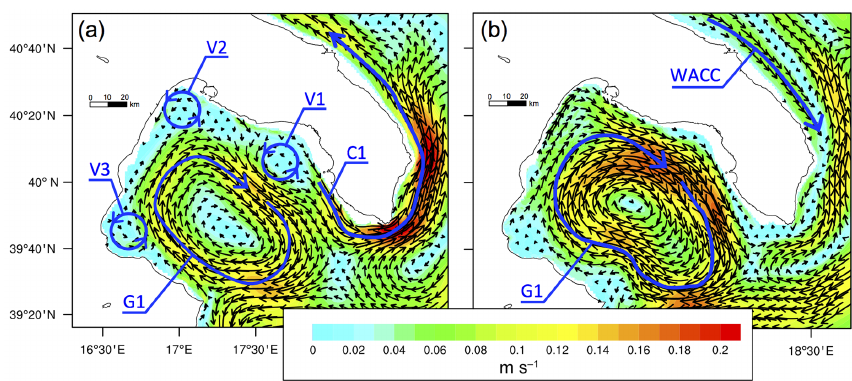
Figure 14. General circulation of SANIFS in Gulf of Taranto for (a) 1–3 October 2014 (LS2) and (b) 8–11 October 2014 (SCS and LS2).